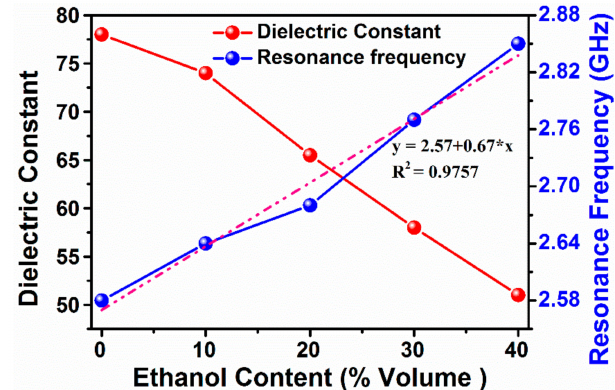
Figure 11. Simulated results variation of resonance frequency with ethanol content and dielectric constant linearity